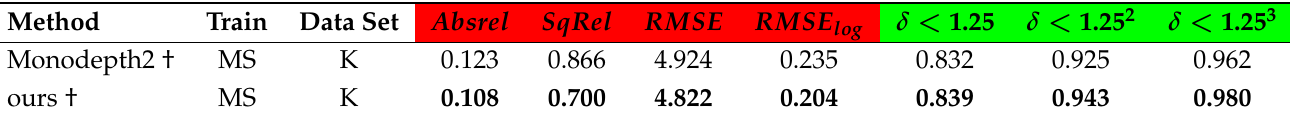
Table 3. Comparison of performance on the VKITTI2 data set. The best results are indicated in bold. MS, trained on stereo pairs; MS, trained on calibrated binocular videos; †, using post processing steps. The metric in red is better. The metric in green is better.